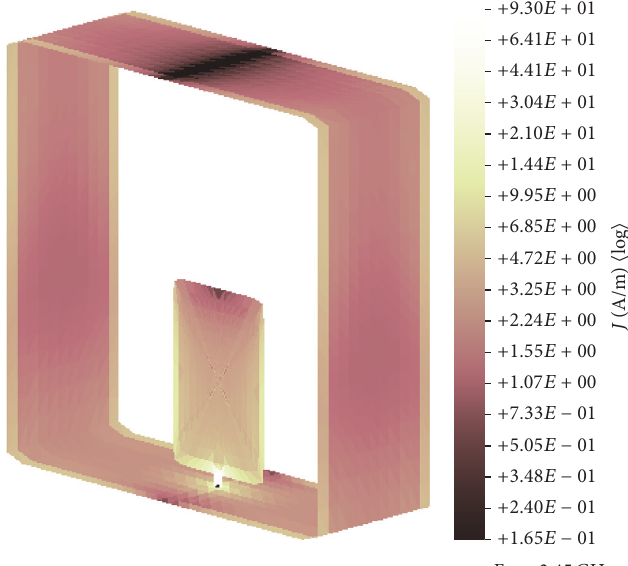
Figure 11: Current density on the proposed model at 2.45 GHz.